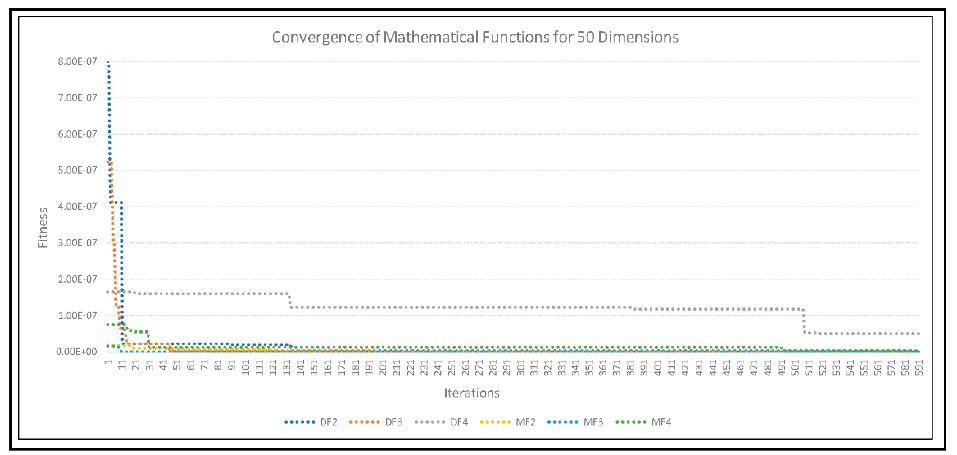
Figure 10. Convergence of the DMOA and MTOA algorithms for 50 dimensions, for the functions F2, F3, and F4.